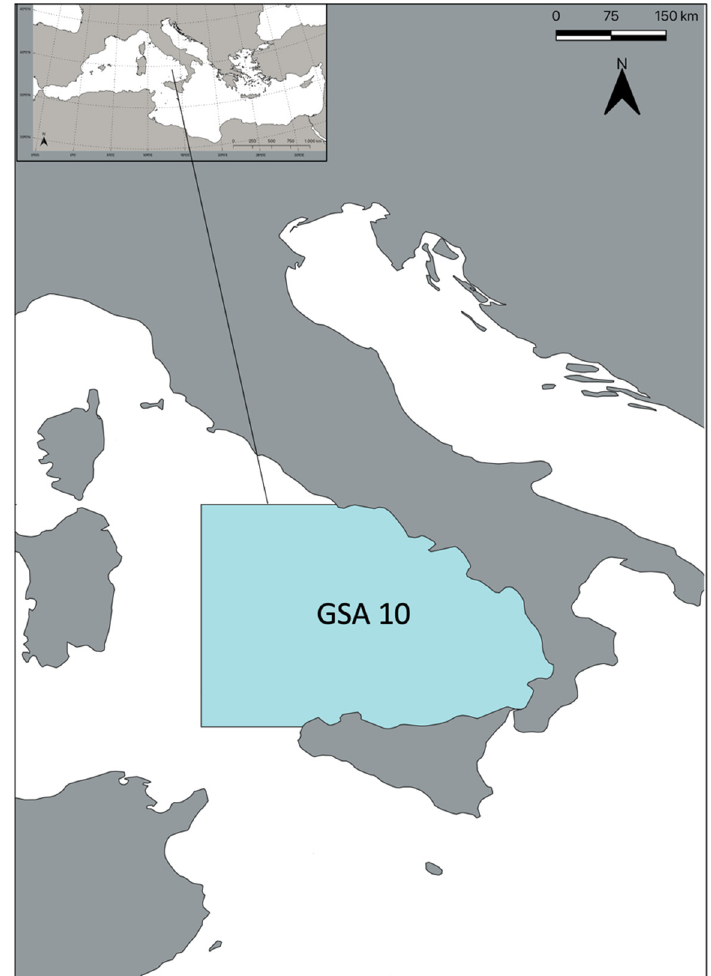
Figure 1. Maps of the studied area (GSA 10, southern and central Tyrrhenian Sea), Mediterranean Sea in the insert.